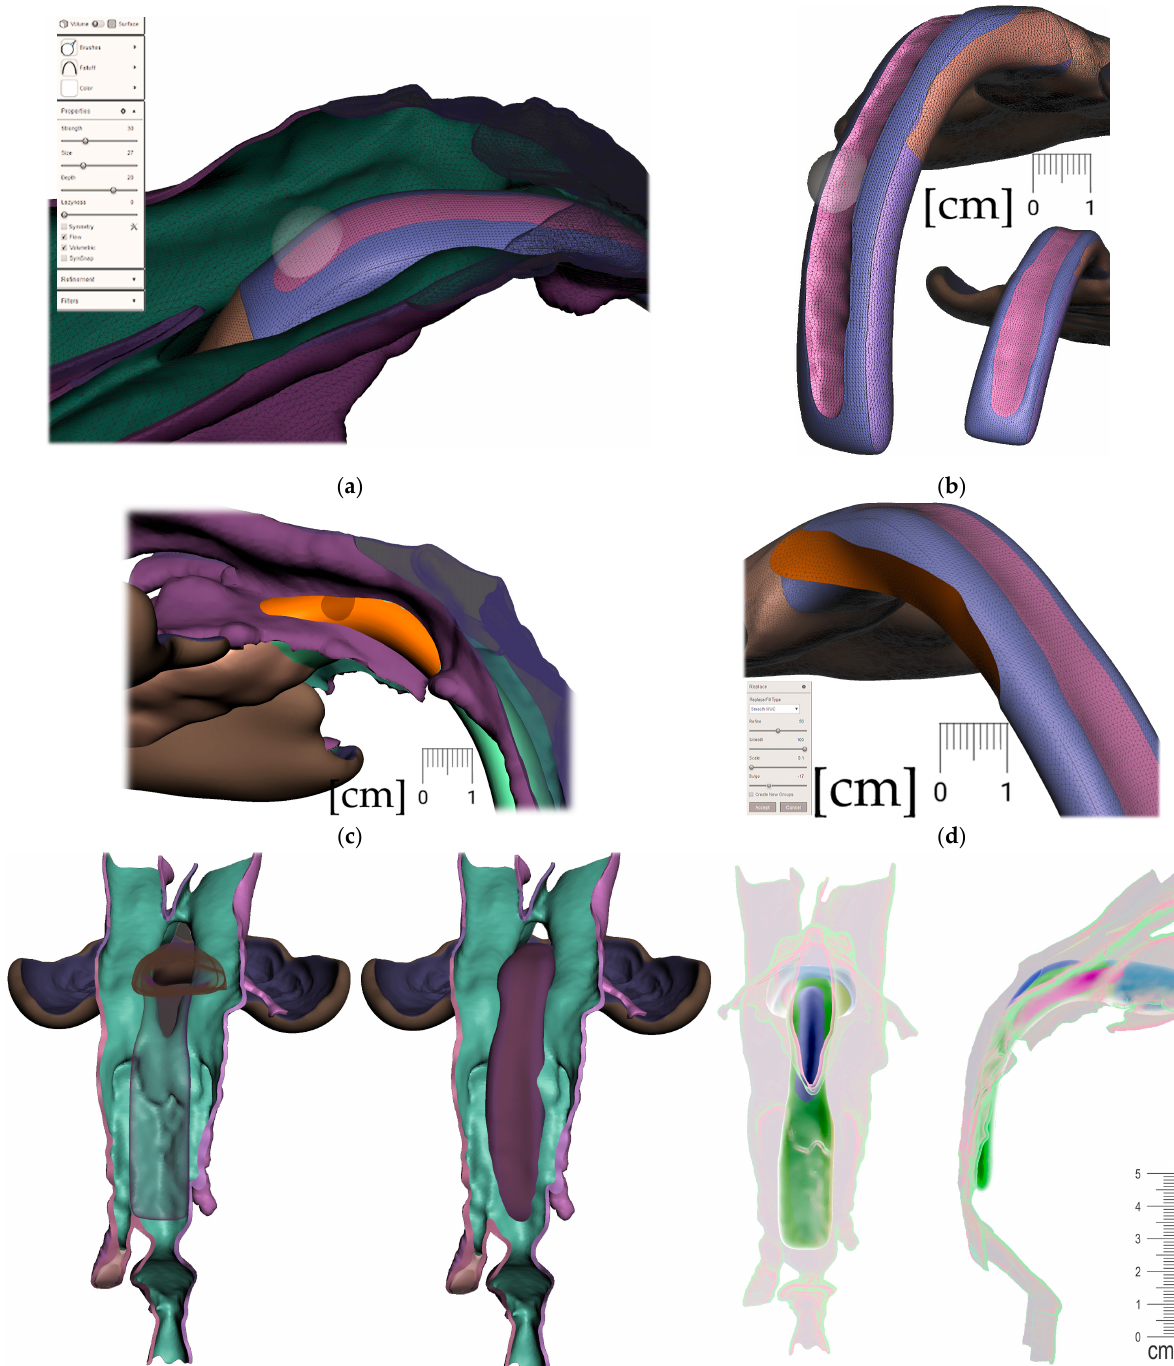
Figure 13. Pharyngeal part creation (the spur)—Spur profile anatomical adaptation: ( a ) select Sculpt tool and Volume Brush “Drag” define shape adaptations of the spur; ( b ) longitudinal groove impression increases resilience of the spur; ( c ) select and optimize selection– keystroke “O”, and smooth boundaries “B”; ( d ) with selected area Edit -> “Erase and fill” Keystroke “F” to reduce or bulge defined areas; ( e ) posterior and lateral views of spur placement in the pharynx with planned propulsion of the soft tissues in this area. Use Shaders menu to set the spur transparency to evaluate anatomical placement and distance from the epiglottis.